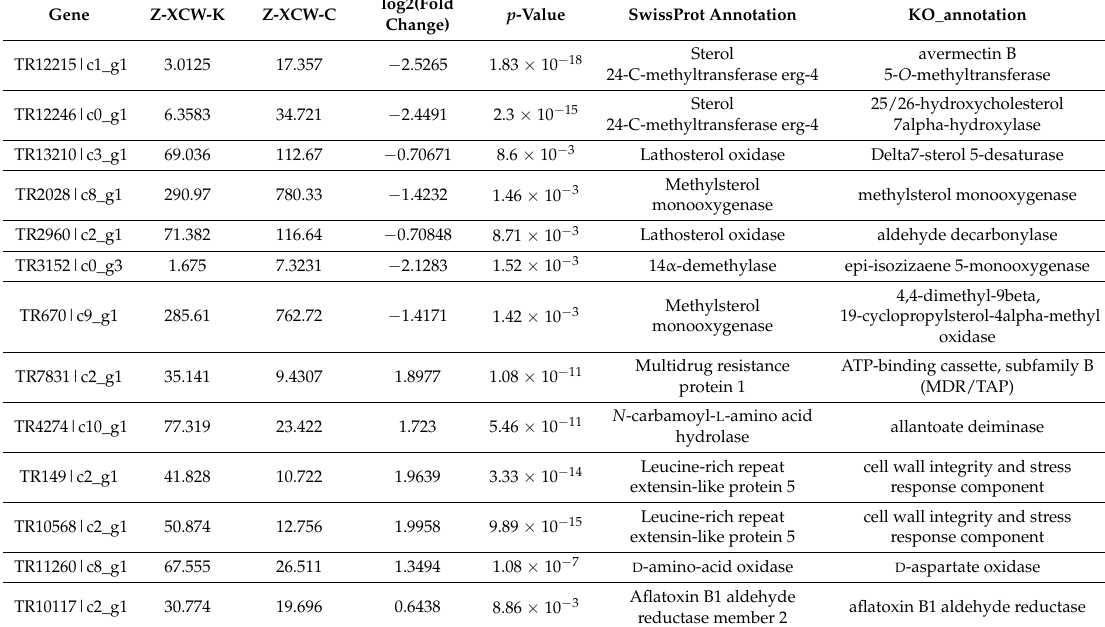
Table 7. Select significantly expressed genes of clotrimazole (Z-XCW-K) vs. control (Z-XCW-C) in the transcriptome